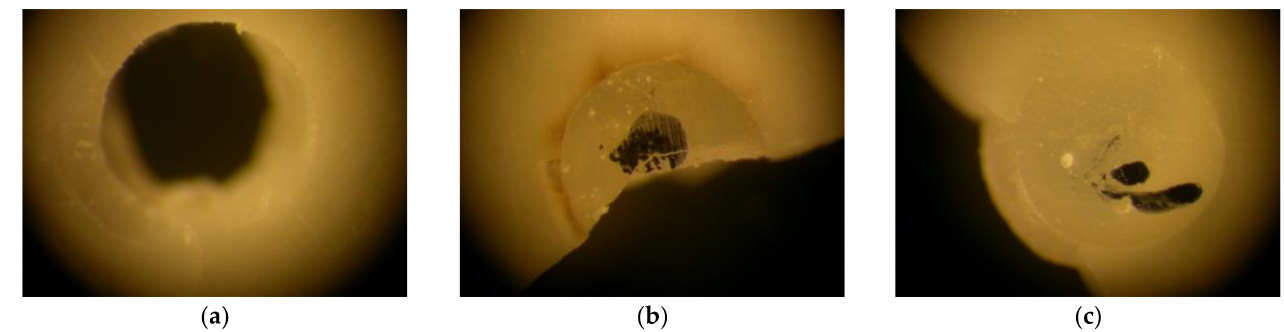
Figure 1. Failure types: ( a ) Adhesive (A); ( b ) Cohesive (C); ( c ) Mixed (M).